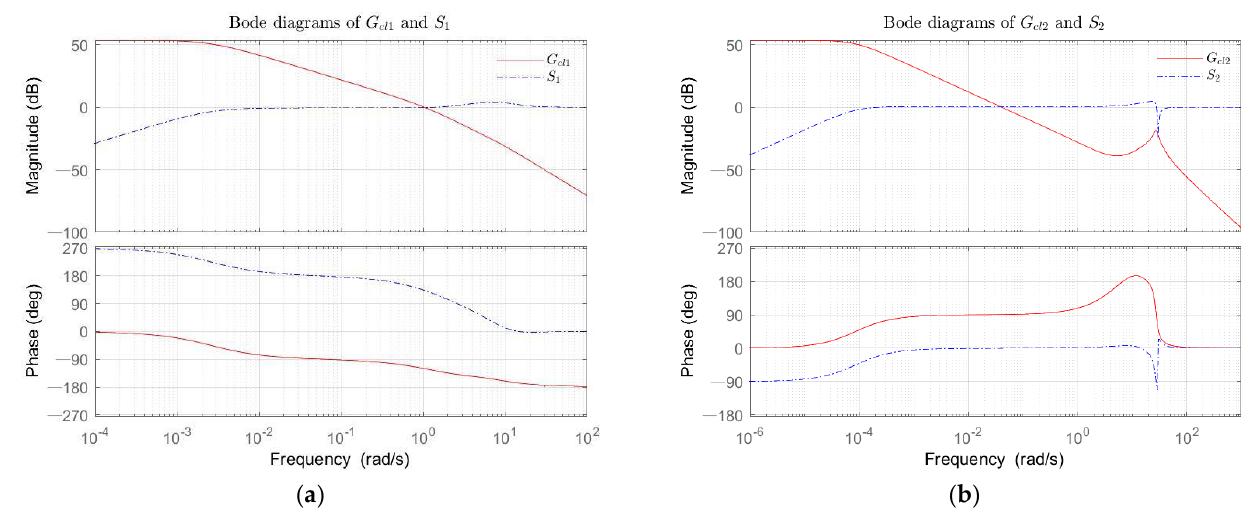
Figure 6. The Bode plots. ( a ) The Bode diagrams of closed-loop transfer function 𝑮 𝒄𝒍𝟏 (rad solid-line), the sensitivity transfer function 𝑺 𝟏 (blue dotted-line); ( b ) The Bode diagrams of closed-loop transfer function 𝑮 𝒄𝒍𝟐 (rad solid-line), the sensitivity transfer function 𝑺 𝟐 (blue dotted-line).